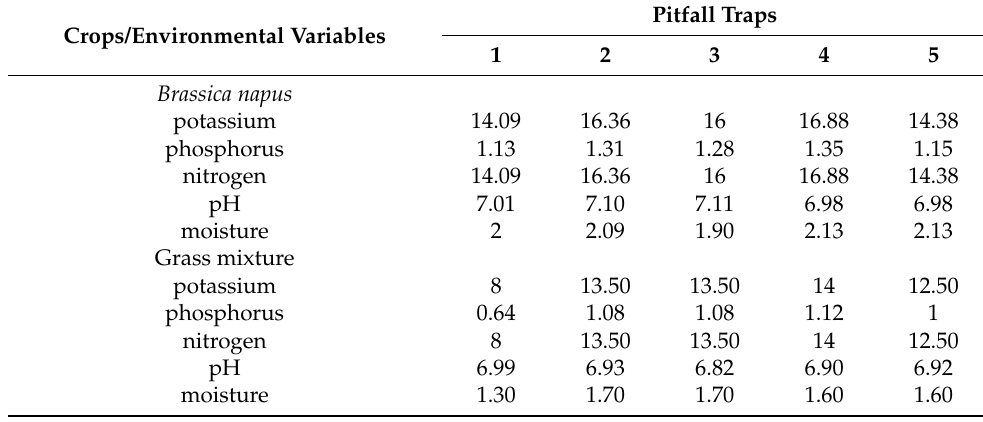
Table 1. Average values of environmental variables during 2018–2020 for the studied crops. Crops / Environmental Variables